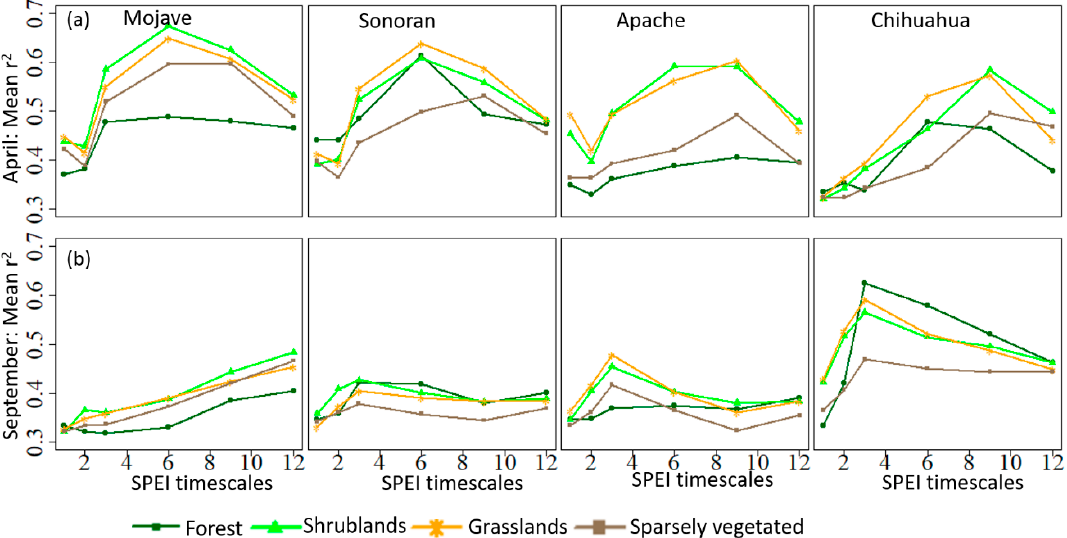
Figure 9. Mean r 2 computed from the correlation matrices of NDVI and different SPEI timescales based on the different vegetation types by each ecoregion for April (winter: a ) and September (summer: b ).